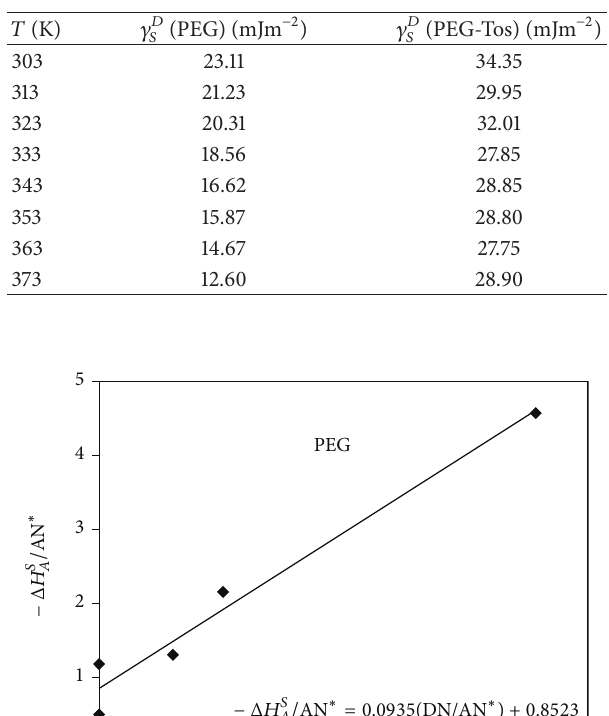
Table 1: 𝛾 𝐷 𝑆 values of PEG and PEG-Tos at studied temperatures calculated by Fowkes method.